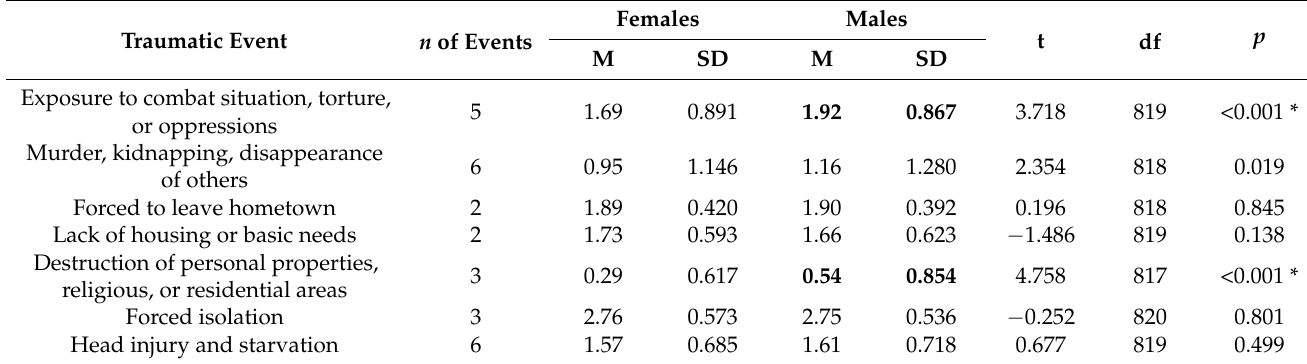
Table 2. Gender differences in exposure to common traumatic events.